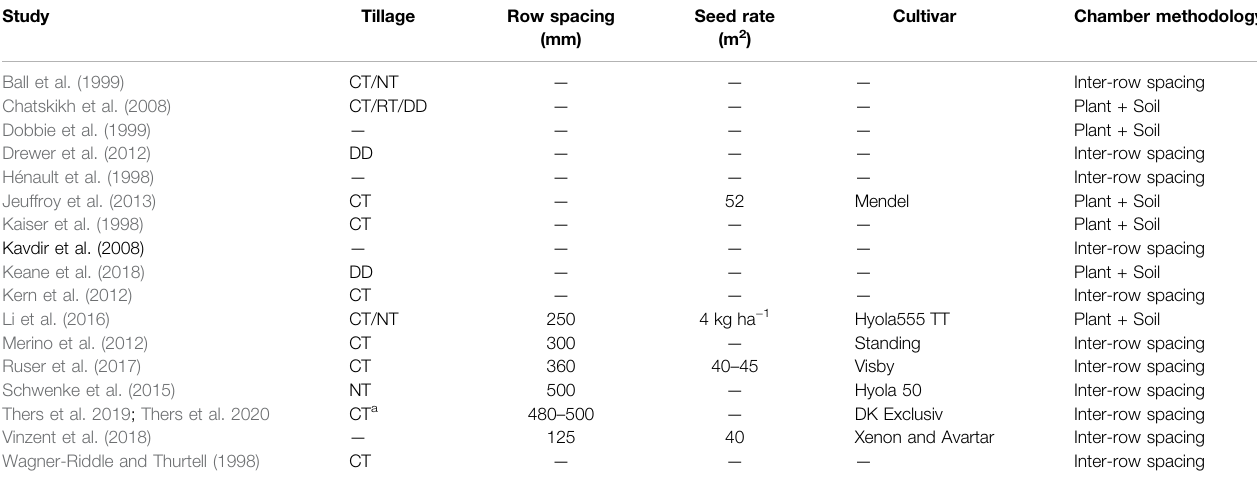
TABLE 1 | Management practices and GHG emission measurement methodologies as described in previous studies of OSR.